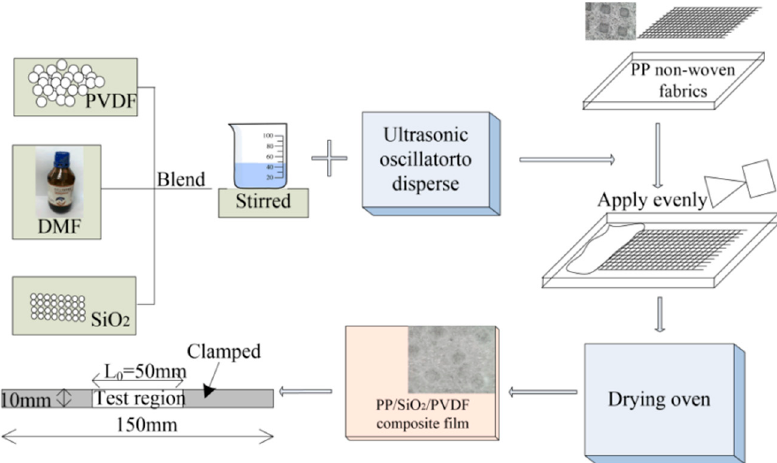
Figure 1. Composite material production flow